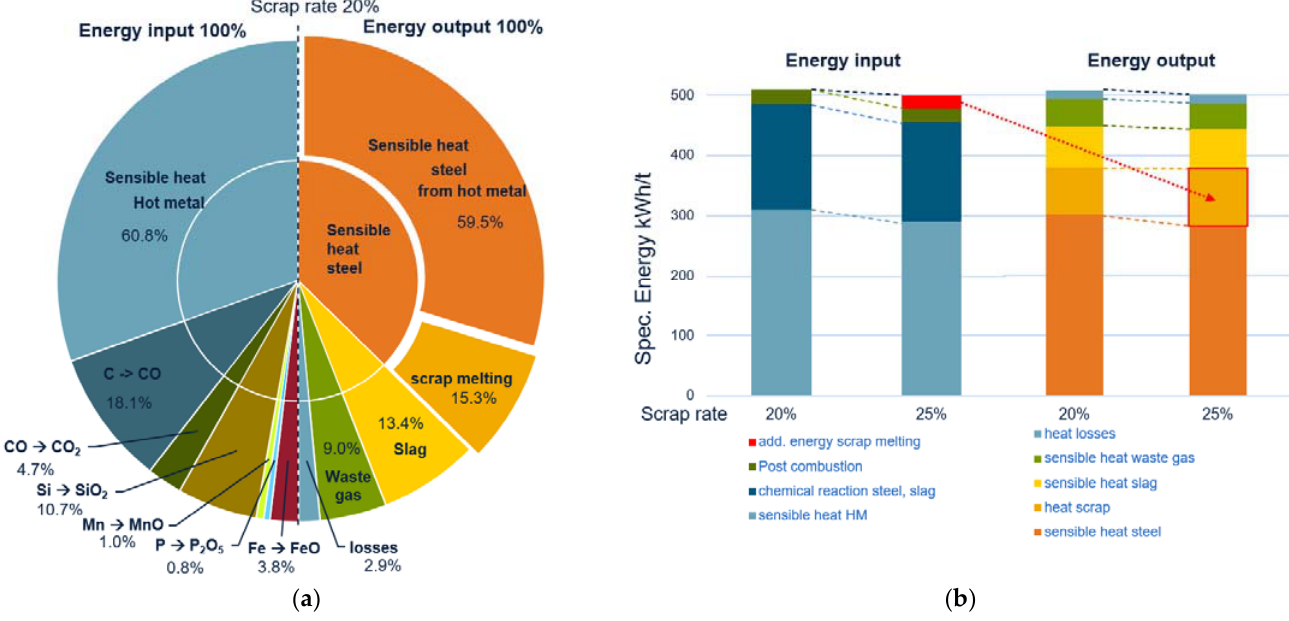
Figure 4. ( a ) BOF energy balance for 20% scrap rate ( b ) comparison of energy input and output for 20% and 25% scrap rate.